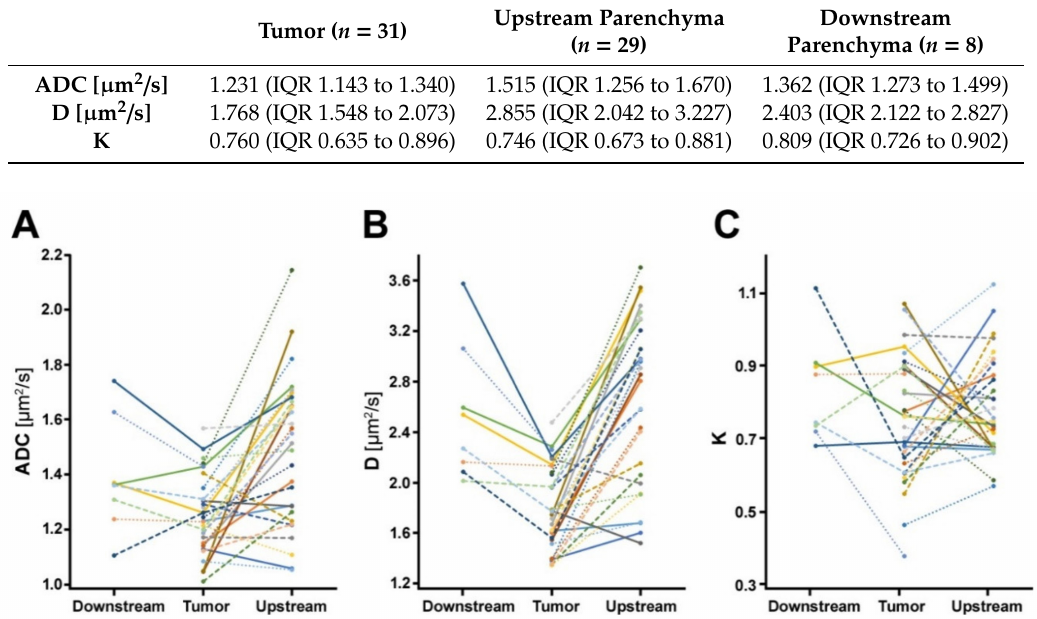
Table 1. Median ADC, D, and K values with interquartile ranges (IQR) for all PDAC patients.